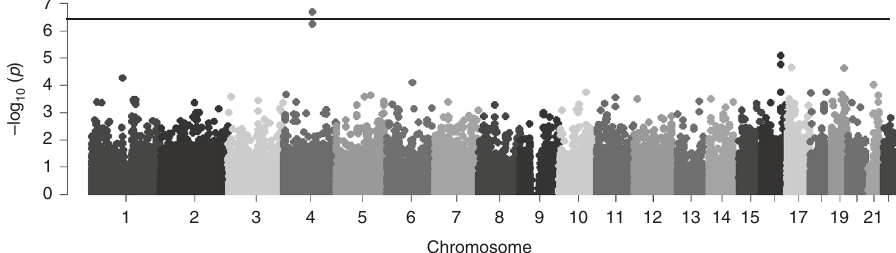
Fig. 1 Manhattan plot showing AIS exome-wide association results. Linear regression p -values ( − log10) for 52,480 single-nucleotide polymorphisms with minor allele frequency > 0.01. One SNP (rs13107325) was signi fi cantly associated with AIS after Bonferroni correction for multiple